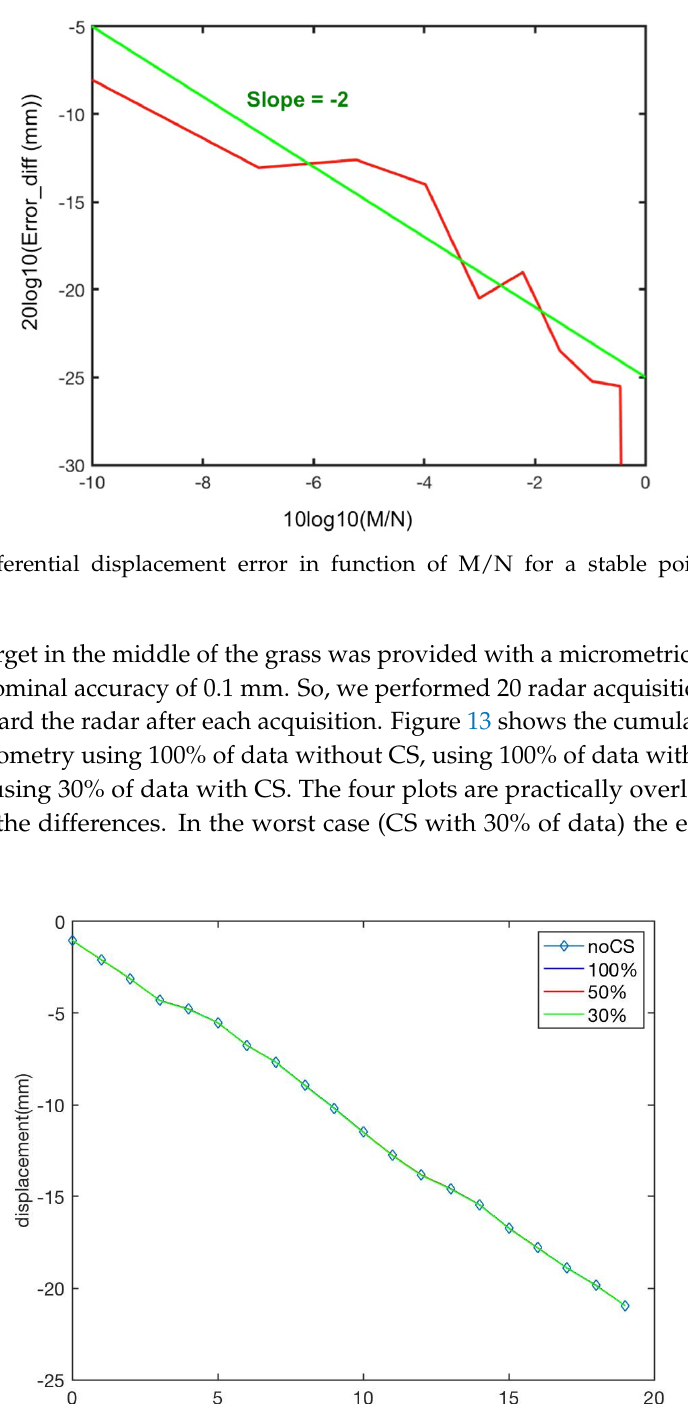
Figure 11. Displacement error in function of M/N for a stable point in the test site “Campus”.